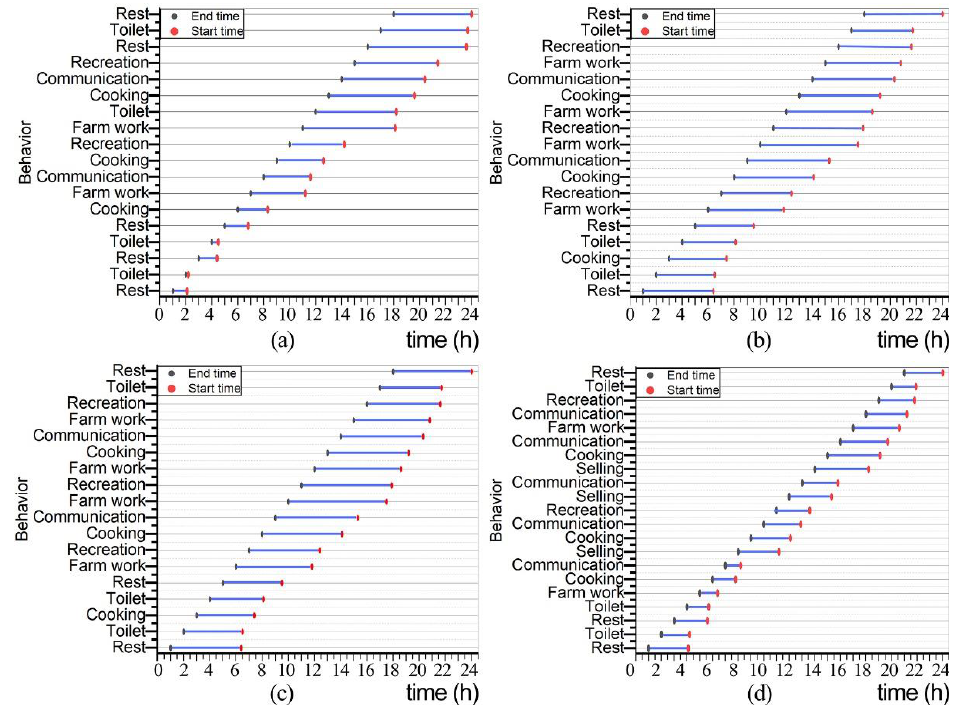
Figure 6. Survey results on the behavioral characteristics of the elderly in ancient towns. ( a ) Zuozi dwelling, ( b ) L-shape dwelling, ( c ) front store and back house dwelling, ( d ) lower store and upper house dwelling.